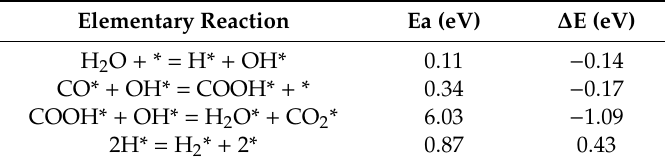
Table 11. Activation energy (Ea) and reaction energy ( ∆ E) of elementary reactions on the Au 32 Pt 6 nanocluster, data from